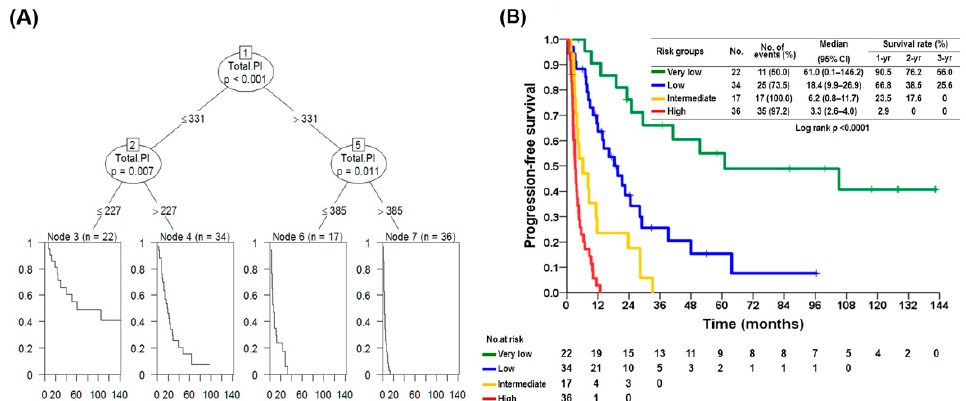
Figure 3. Survival analysis tree and Kaplan–Meier plot by nomogram points. ( A ) A survival analysis tree was used and to establish an optimal cut-off point to better predict the recurrence. ( B ) Kaplan–Meier plot of the PFS of 109 patients with advanced GISTs treated with sunitinib in terms of risk with different scores. Table 4. Point assignment for each variable and prognostic score for progression-free survival. Predictor Variables Points Assigned